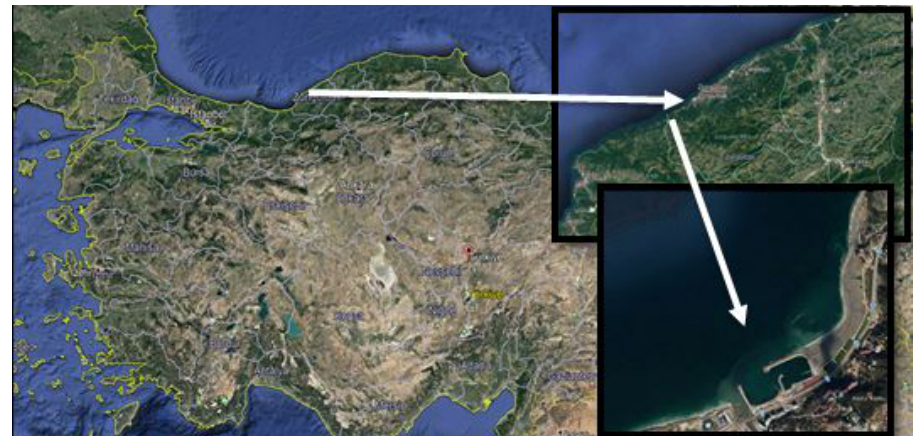
Figure 12. Experimental area from Google Earth view.